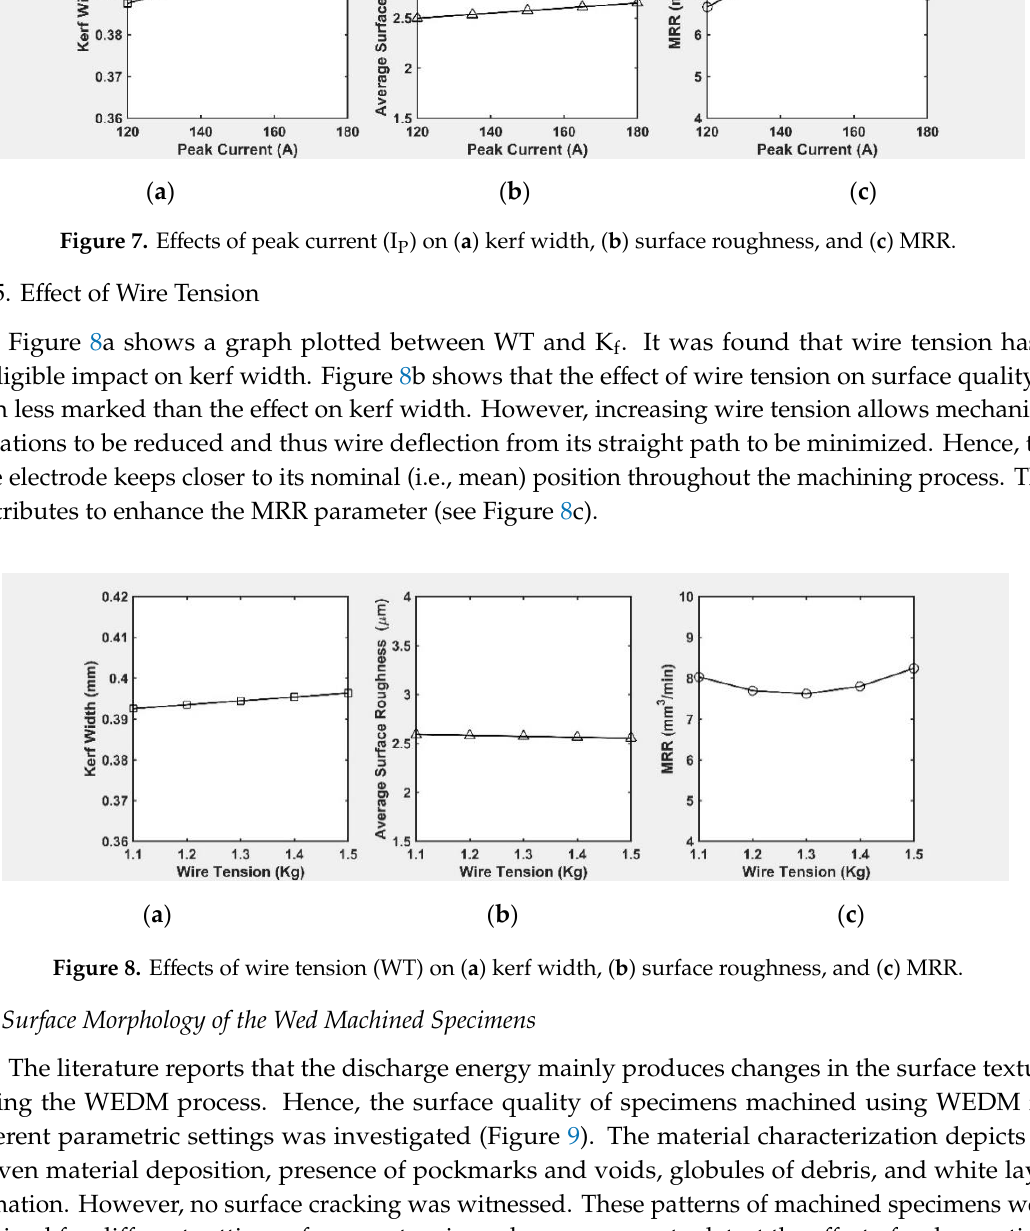
( c ) Figure 6. Effects of servo-voltage (SV) on ( a ) kerf width, ( b ) surface roughness, and ( c ) MRR. 3.5.4. Effect of Peak Current The graph plotted in Figure 7b between I P and R a shows that the surface roughness increases from 2.4 µm to 2.7 µm with the increase in peak current value due to the increase in discharge energy.